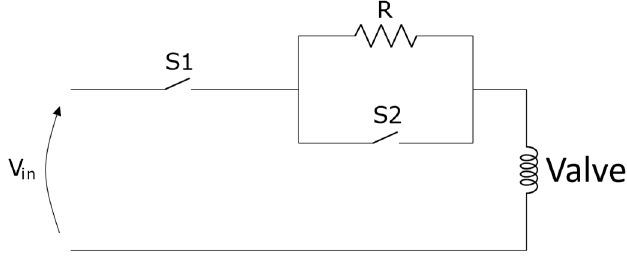
Figure 2. Valve control circuit.